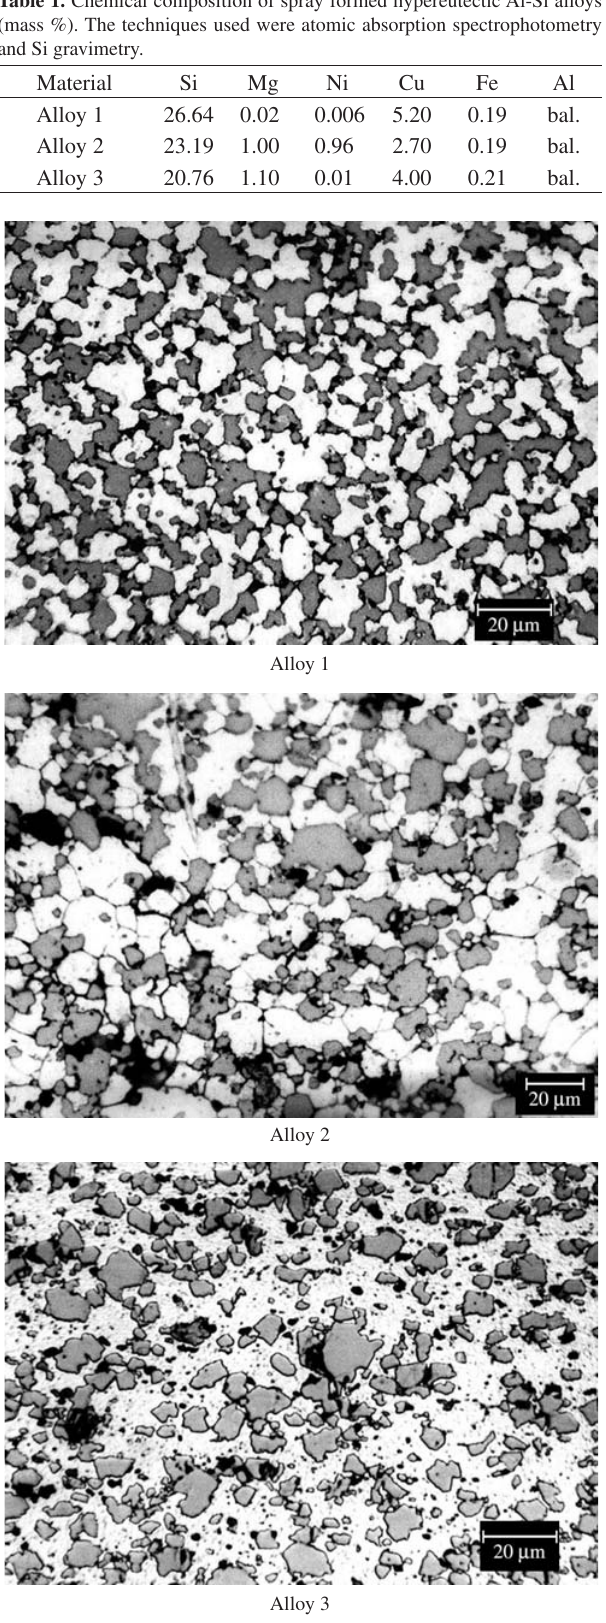
Figure 2. Optical micrographs of the spray formed alloys 1, 2 and 3, showing the homogeneity of the silicon particles distribution (light grey phase) in the aluminium matrix (white phase).